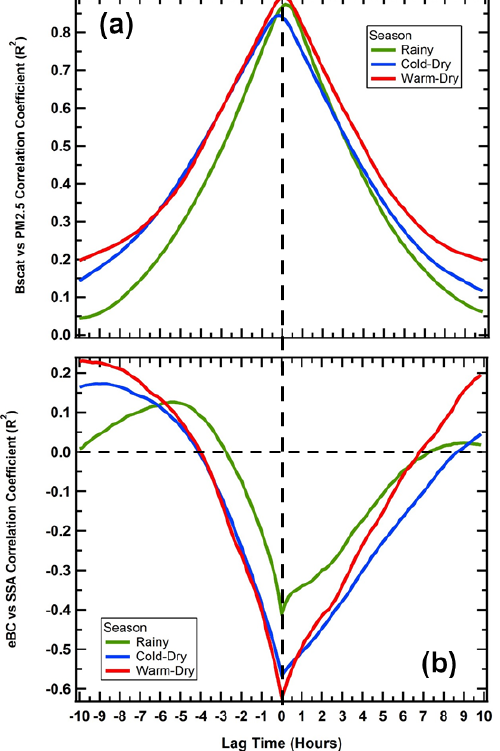
Figure 12. As in Fig. 11, these plots illustrate the correlations be- tween (a) eBC and CO, and (b) eBC and PM 2 . 5 , as a function of the lag time and differentiated by season.